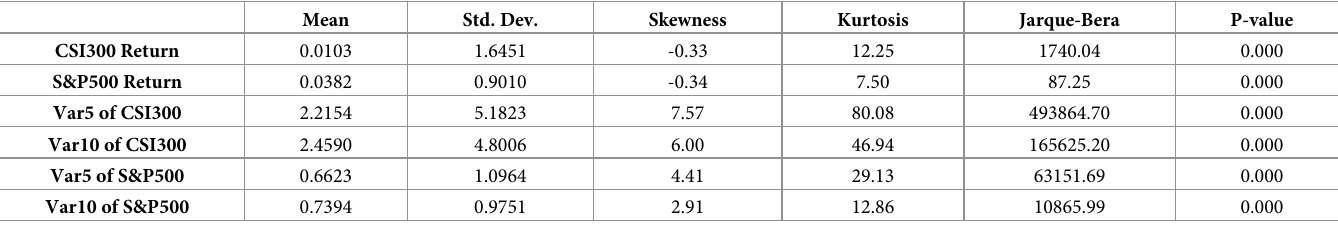
Table 2. Summary statistics of CSI300 and S&P500 index